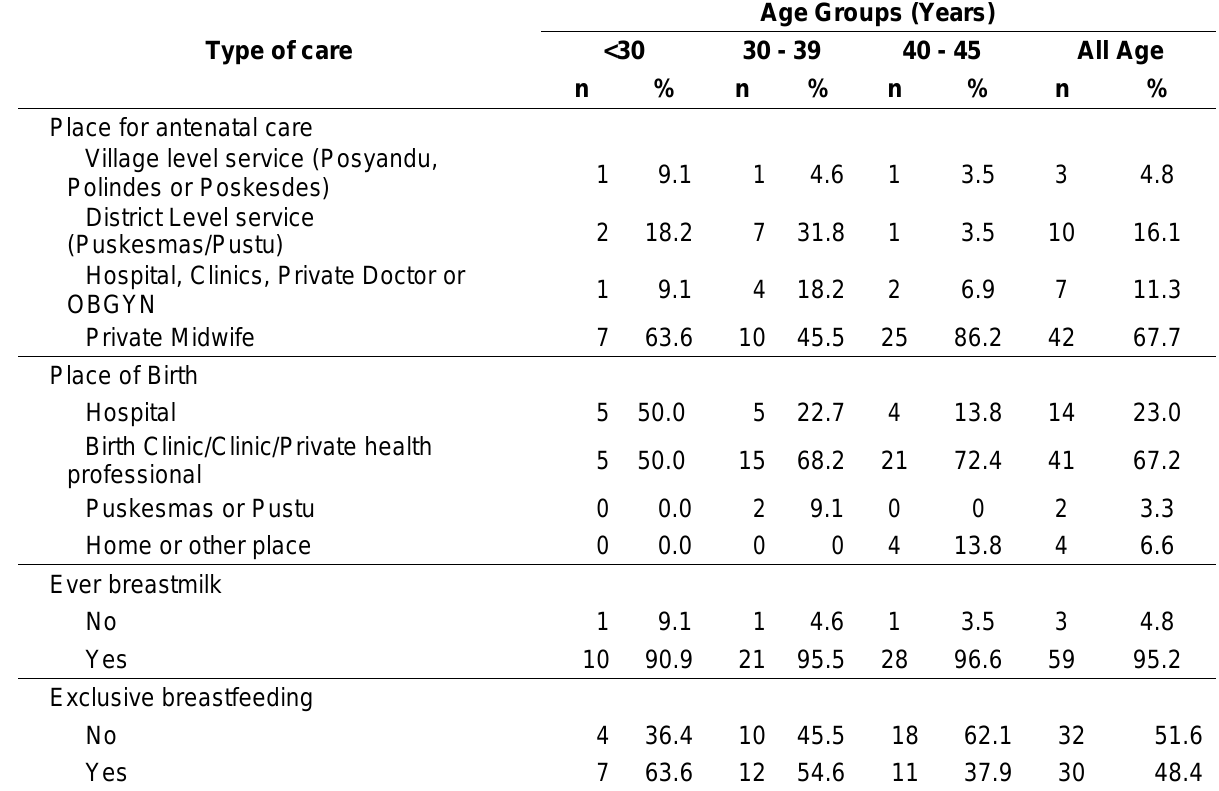
Table 3. Maternal and child health care-seeking behaviour for the last pregnancy in women aged 15 – 45 years